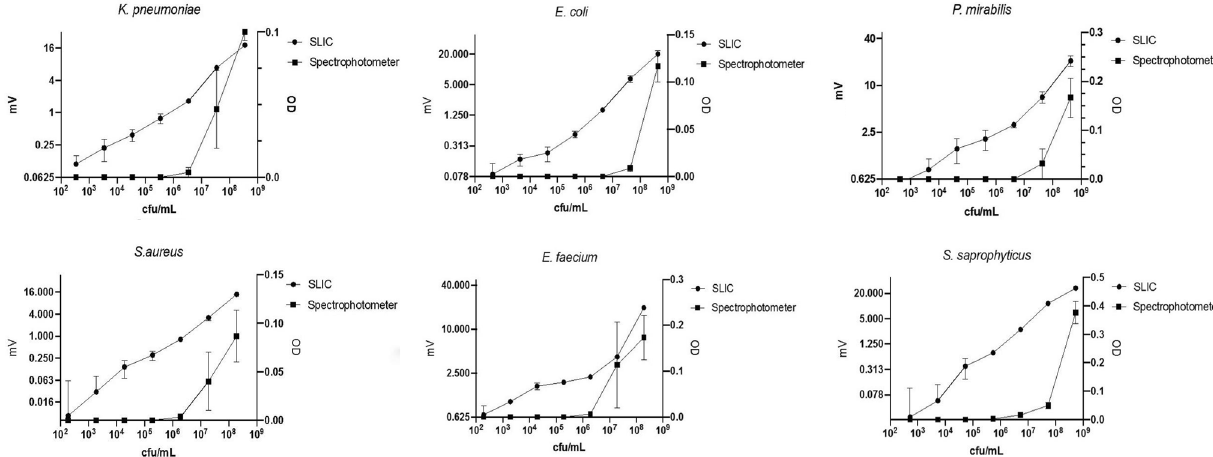
Figure 2. Bacteria of each species were resuscitated from glycerol stock and inoculated into Mueller–Hinton cation adjusted (MH+) media (Sigma) and allowed to incubate overnight (~ 16 h). Seven serial 1:10 dilutions with 100 µL of culture in 900 µL of MH+ media in sterile microcentrifuge tubes (Axel, Germany) were carried out. Each serial dilution was aliquoted into sterile cuvettes, capped and measured in a spectrophotometer (Biochrom WPA CO8000, UK) using sterile MH+ media as a blank. All experiments were performed in triplicate to provide the sensitivity of the spectrophotometer. The same samples were transferred to the SLIC v7 device and scattering signal acquired over 10 s. The average of the three data points were collected. The cuvettes were removed from the SLIC device and for each 3 × 10 µL was aliquoted onto a MH+ agar plate and the number of viable organisms determined by a modified Miles and Misra 7 . Mean values for both parameters were plotted together with the standard error of the